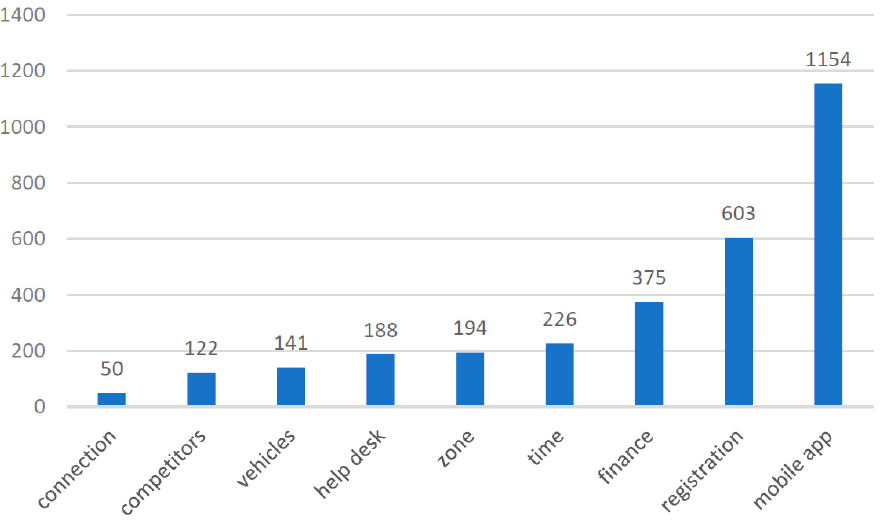
Figure 13. The number of keywords in negative and neutral comments by category.